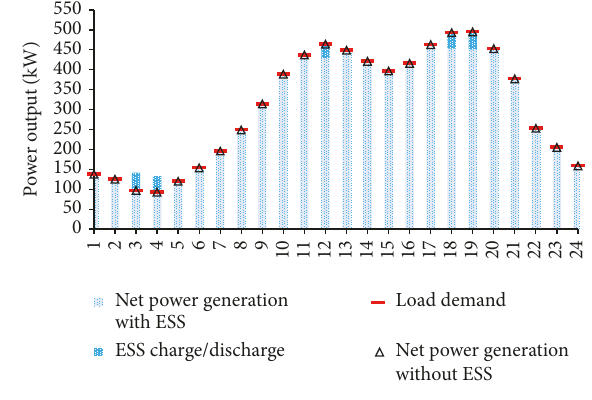
Figure 4: Supply and demand condition in Case